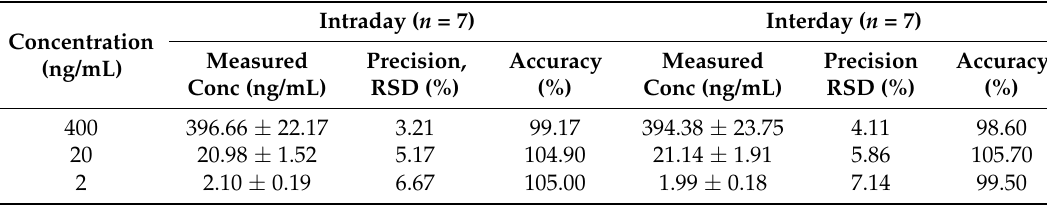
Table 1. Intra and interday precision and accuracy of vancomycin in serum. Table1. Intra and interday precision and accuracy of vancomycin in serum.